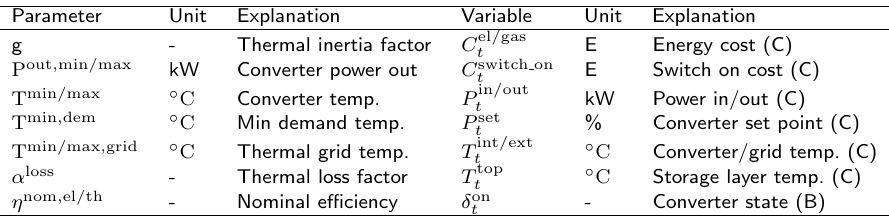
Table 1 Parameters and variables of the model. (C: continuous, B: binary, t: time step) Parameter